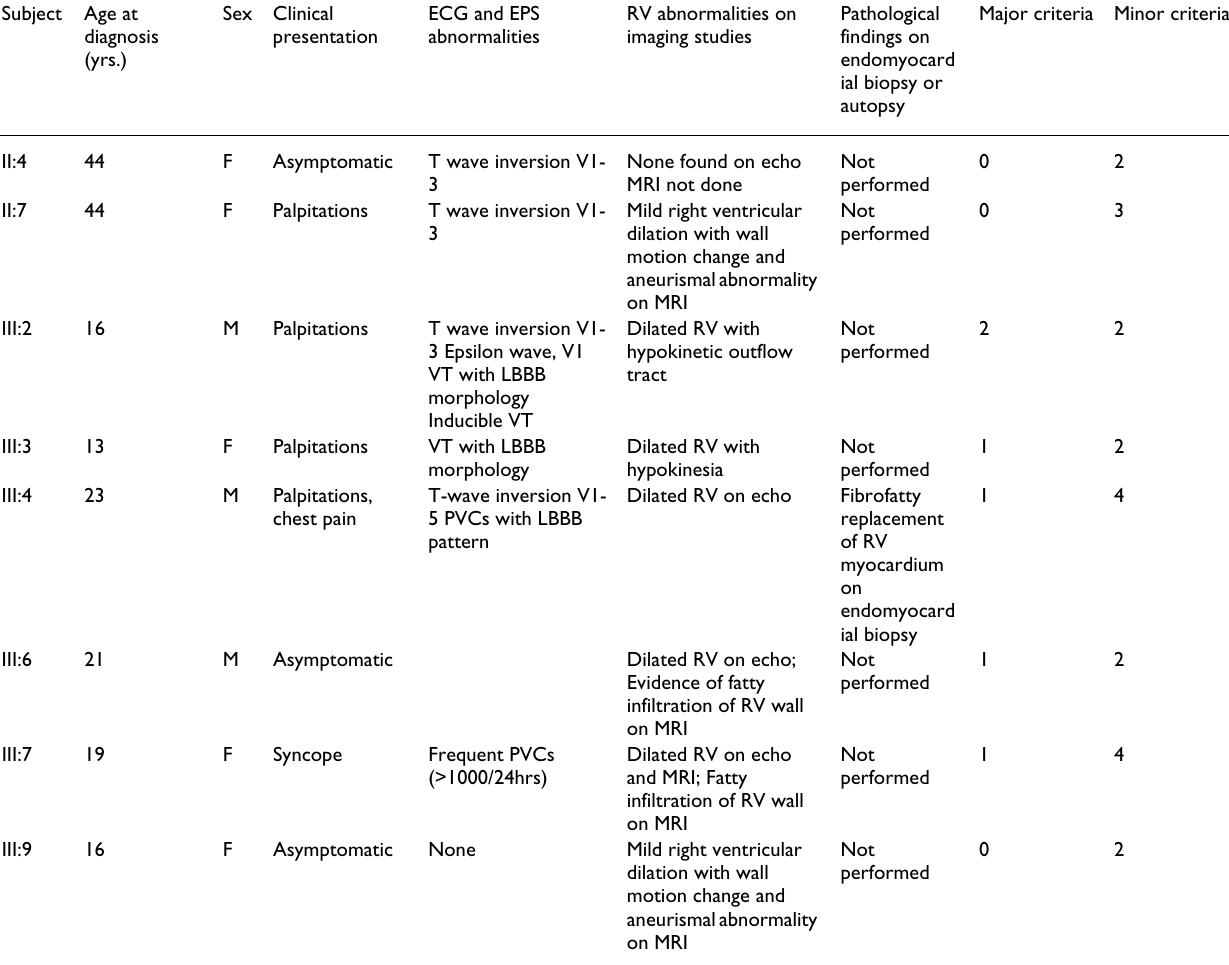
Table 2: Clinical features of affected members with familial arrhythmogenic right ventricular cardiomyopathy. Subject Age at diagnosis